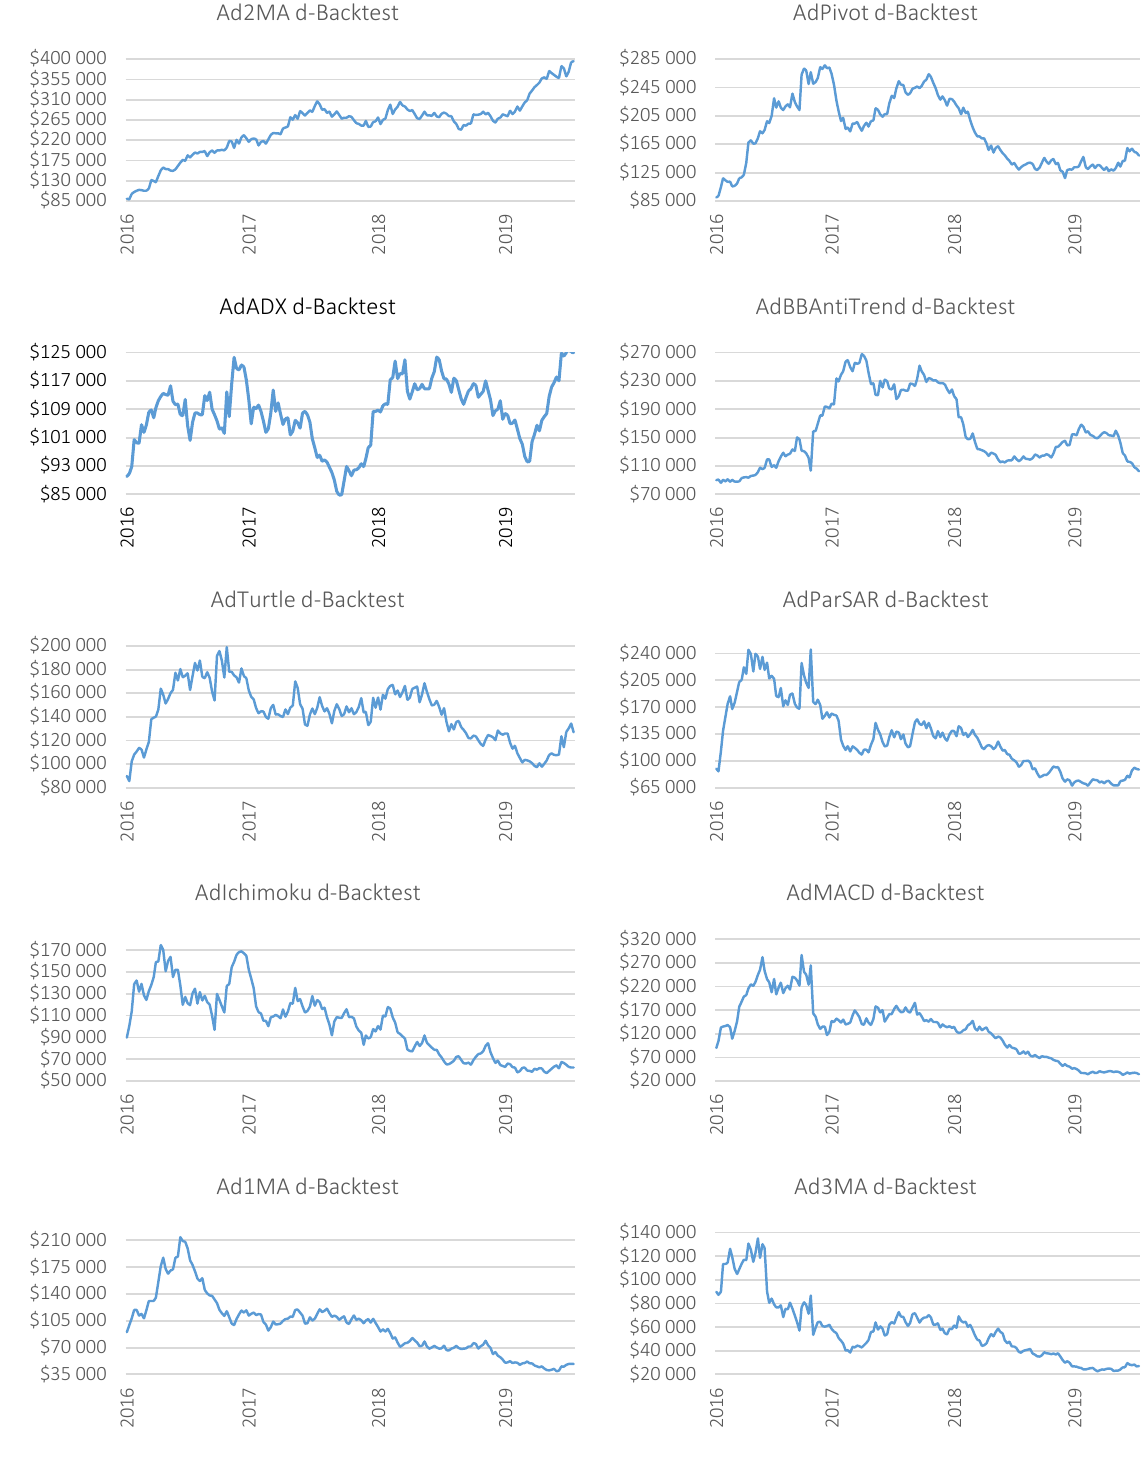
Figure 1. Systems’ 3.5-year balance graph (January 2016 – July 2019) with compounding capital using the d-Backtest PS method for parameter